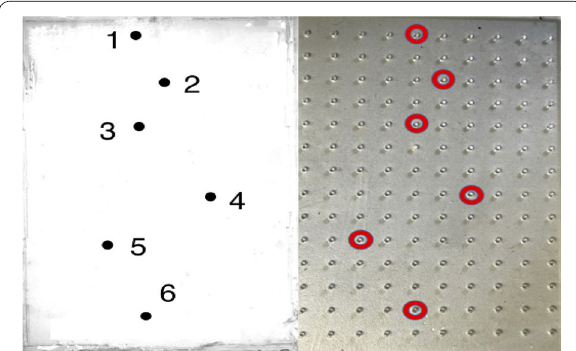
Figure 5 Tensile test of the PVA phantom